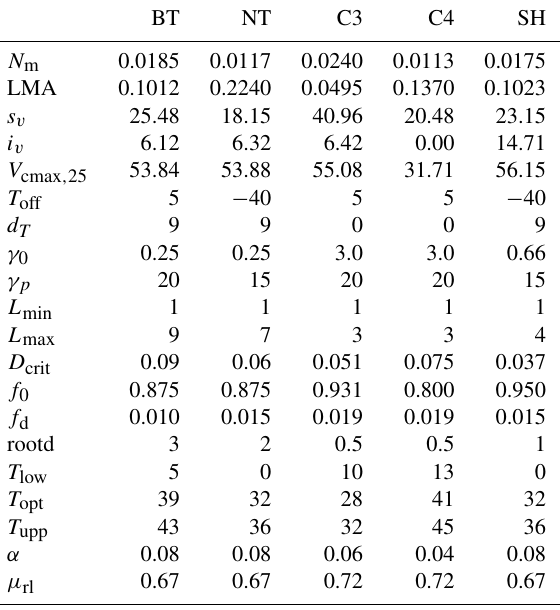
Table A2. New trait-based parameters for five PFTs that are consistent with the data used in this study. Used in the JULES5 ALL